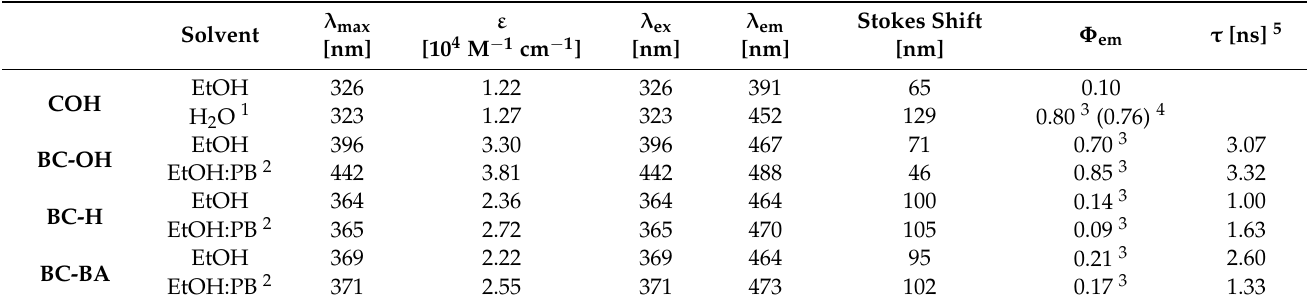
Table 1. Photophysical properties of studied compounds.